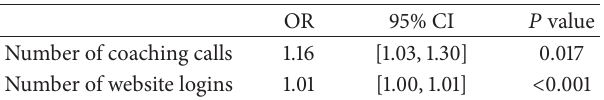
Table 2: Logistic regression of ≥ 5% weight loss at 6 months by program use.